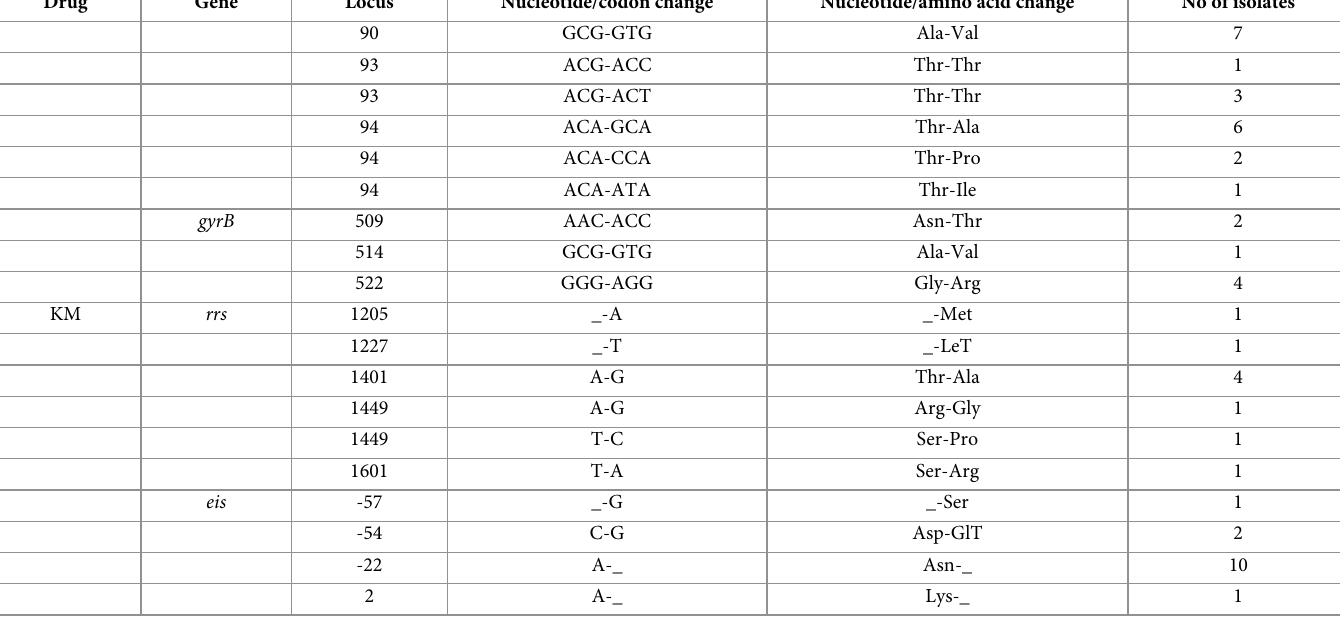
As shown in Table 3, previous treatment history (OR: 2.79, 95% CI: 1.05–7.47, P = 0.04) and receiving a nonstandard treatment regimen (OR: 4.72, 95% CI: 1.55–14.17, P = 0.01) contrib- uted to a poor treatment outcome. We also observed that pncA gene mutation (OR: 5.29, 95% CI: 1.76–15.89, P < 0.01), pncA gene mutation (OR: 5.29, 95% CI: 1.76–15.89, P < 0.01), and (Table 4). We further explored the role of high-frequency mutation sites in the prognosis of MDR-TB but without significant findings (S4